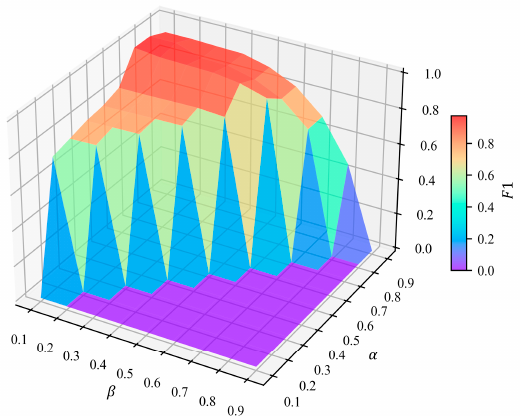
Figure 7. WDBC’s F 1 change chart.